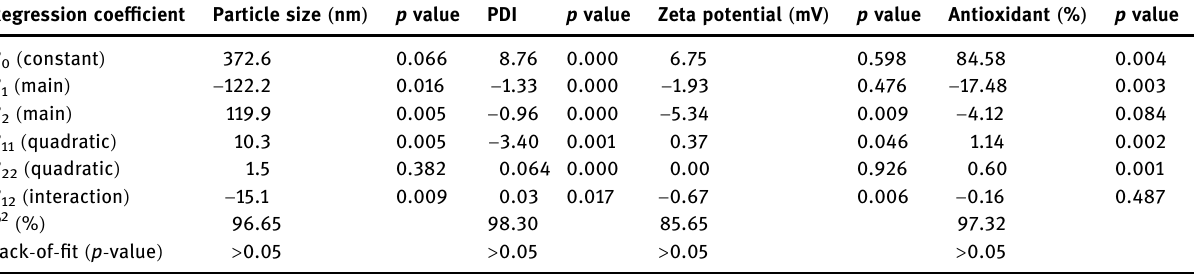
Table 2: Regression coe ffi cients and p values for the generated model terms, and R 2 and lack - o ff - fi t ’ s p - values of the models Regression coe ffi cient